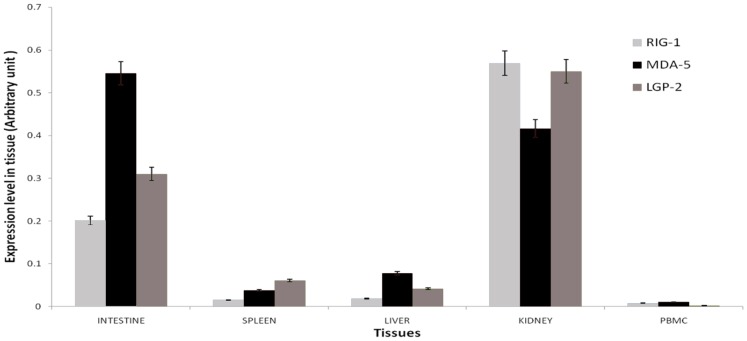
Constitutive mRNA expression levels of buffalo RLR (RIG1, MDA5 and LGP2) genes in different tissues.Relative abundance of mRNA was measured by qRT-PCR using RPS-18 as housekeeping control.